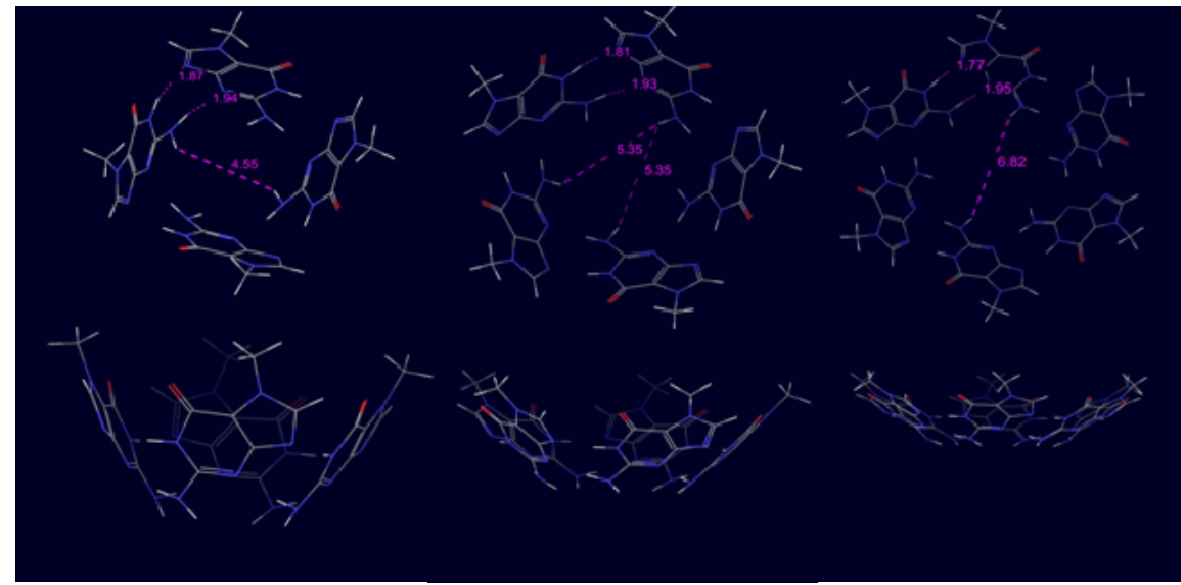
Figure 2. Calculated geometries of 4-, 5- and 6-membered ring conformations of m 7 G (top and side view) with selected distances (in Å).